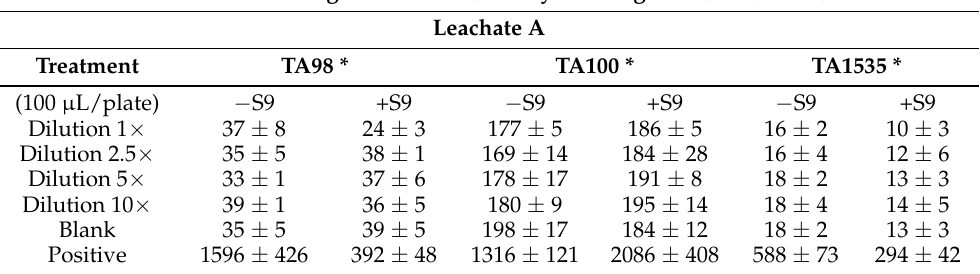
Table 2. Revertant frequency of Salmonella tester strains TA98, TA100, and TA1535 following incubation with leachate A from BFA in presence and absence of S9 mix (mean ± SD is shown).